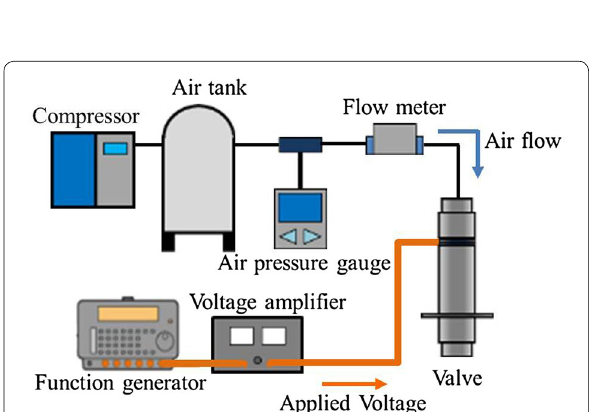
Fig. 14 Experimental setup for flow